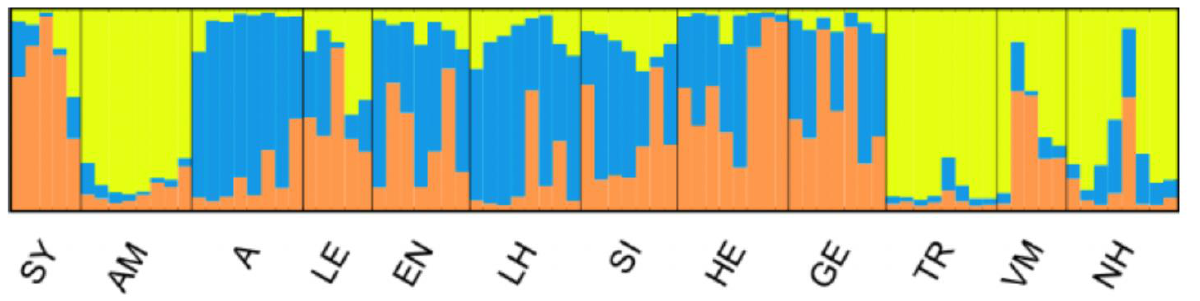
Figure 3. Population genetic structure of 12 Drosera rotundifolia populations as revealed by STRUCTURE analysis using the admixture model for K = 3. Each individual is represented by a vertical bar, and fractional membership in each of the clusters is indicated by colours. Population-IDs according to Table 1.